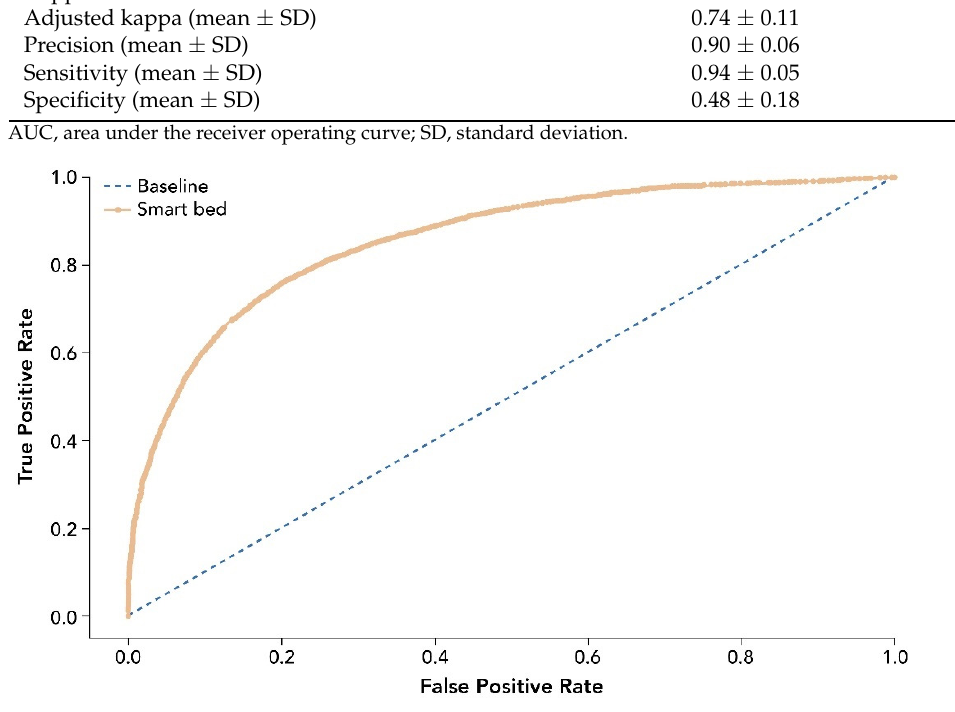
Figure 4. ROC for smart bed prediction of sleep and wake states relative to PSG. The ROC and AUC were assessed as accuracy measures invariant of the prevalence of sleep epochs. The dashed line shows the test with no discriminatory ability (AUC = 0.5). AUC, area under the curve; PSG, polysomnography; ROC, receiver operating characteristic curve.